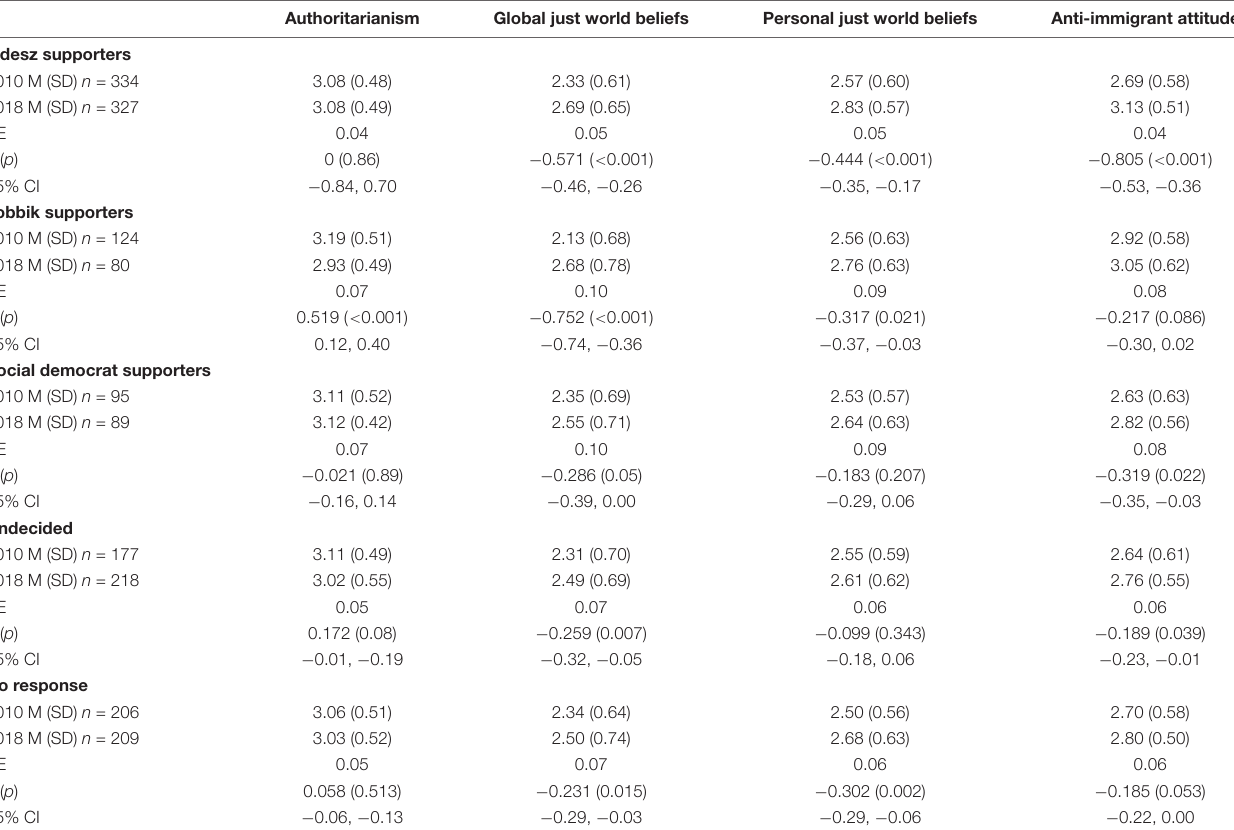
TABLE 1 | Descriptive statistics and effect sizes for comparison between 2010 and 2018 means according to voting